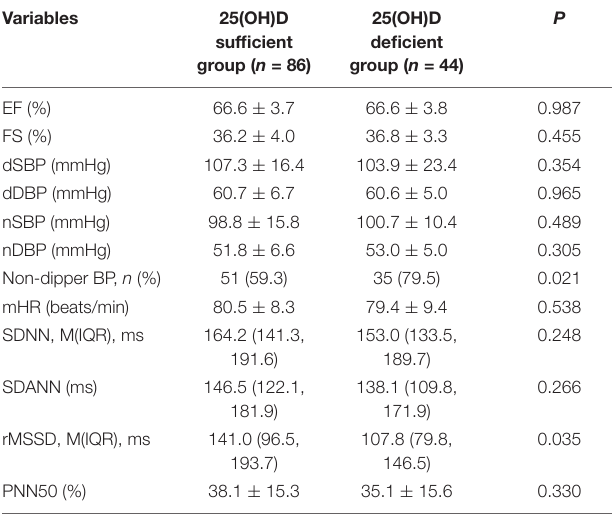
TABLE 3 | Electro-cardiological indictors of patients with vasovagal syncope. Variables